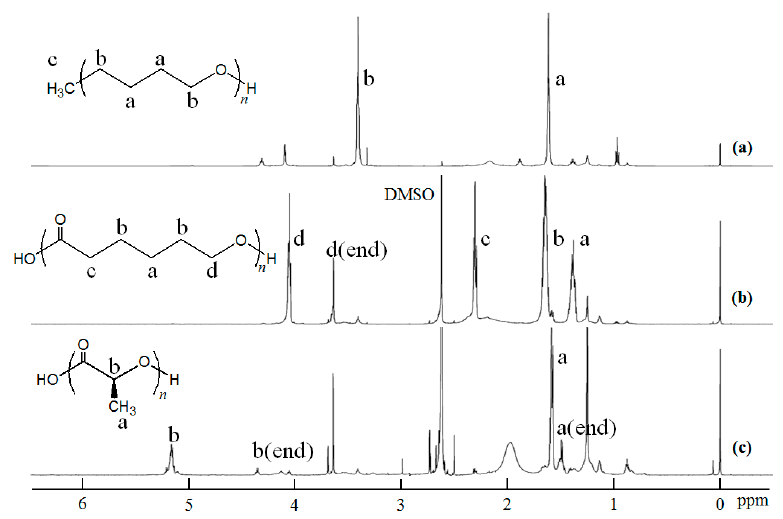
Figure 5. 1 H NMR spectra of: ( a ) chloroform ‐ soluble fraction by treatment of amylose–PTHF inclusion complex in DMSO at 25 °C; ( b ) chloroform ‐ soluble fraction by treatment of amylose–PCL inclusion complex in DMSO at 40 °C; and ( c ) chloroform ‐ soluble fraction by treatment of amylose–PLLA inclusion complex in DMSO at 60 °C (CDCl 3 ).